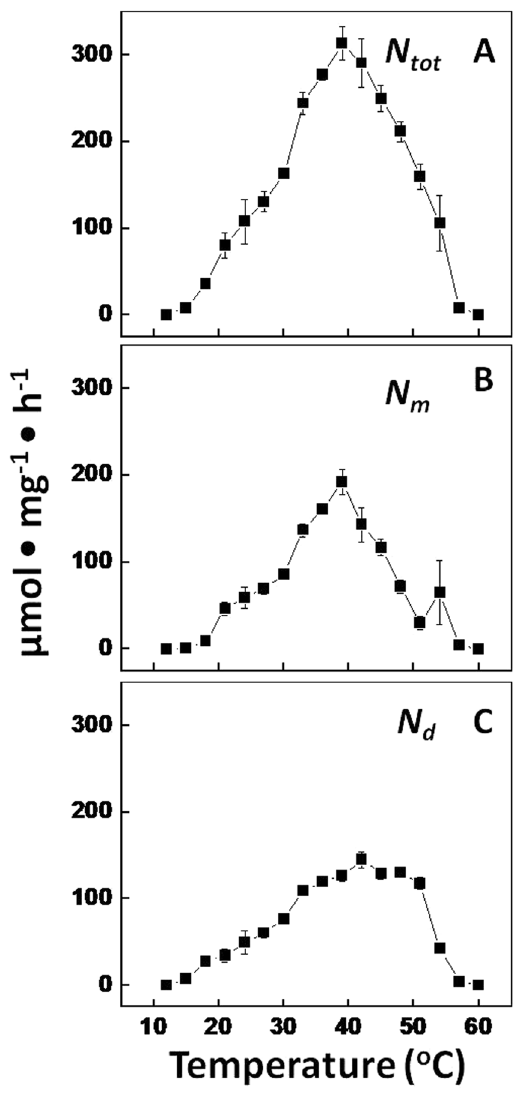
Figure 2. Nitrogenase activity (chlorophyll-specific rate of acetylene reduction) at different temperatures at a fixed